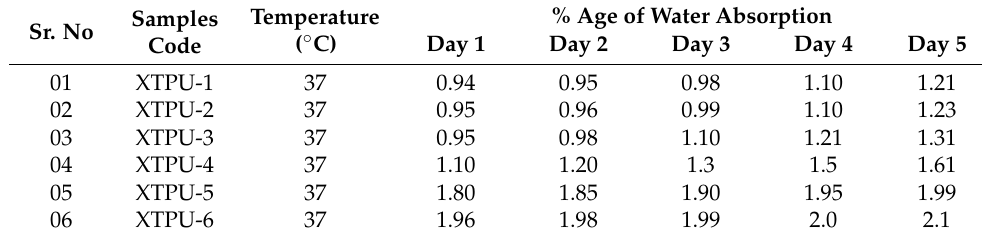
Table 4. Percentage of water